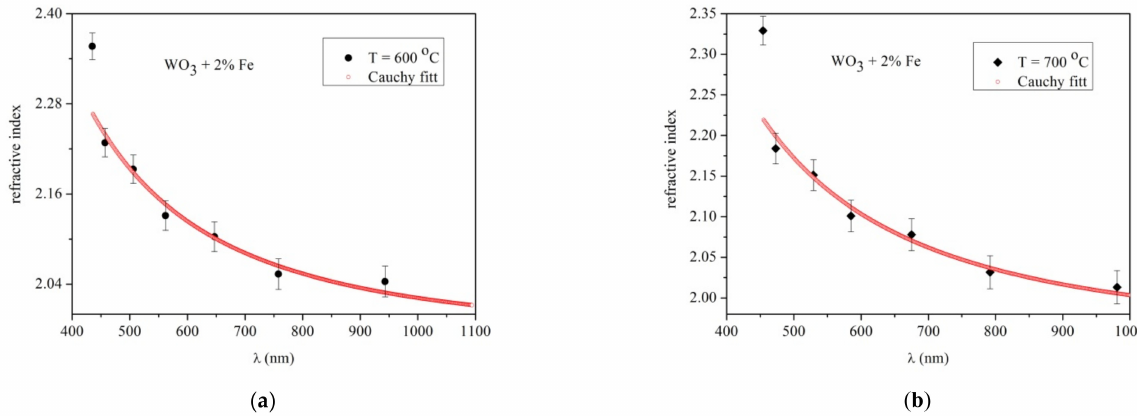
Figure 7. Refractive index plots for 2% Fe doped WO 3 layer grown at 4 h deposition time. ( a ) T = 600 ◦ C; ( b ) T = 700 ◦